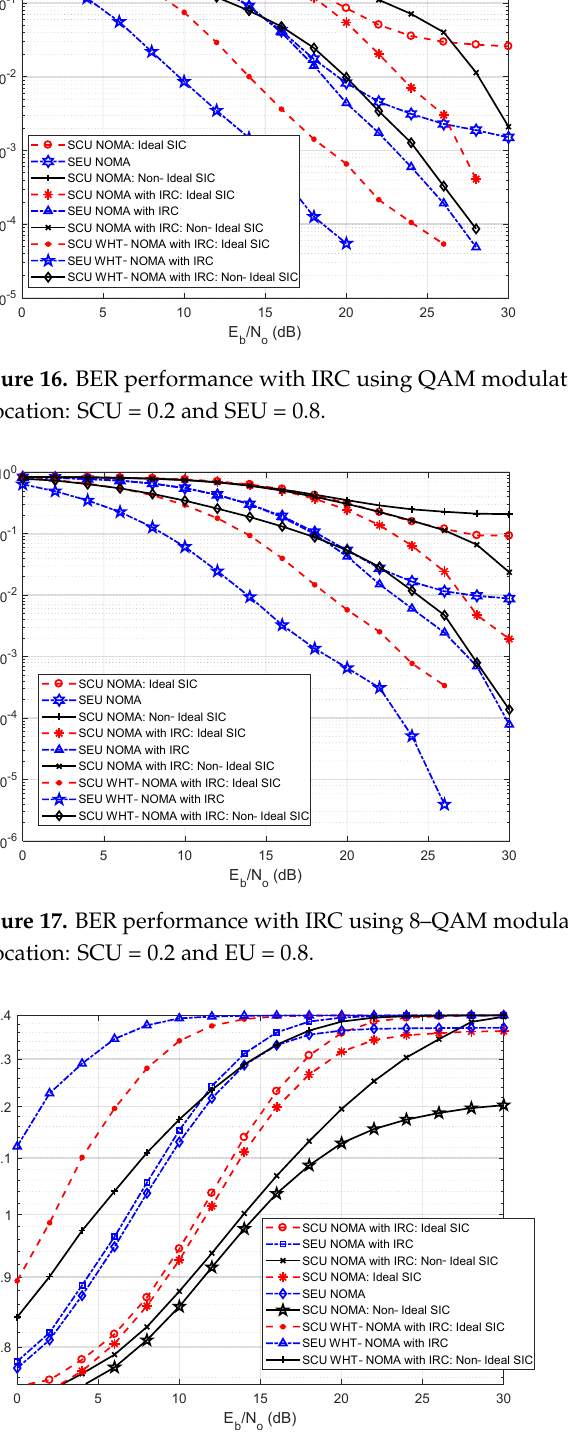
Figure 18. Throughput performance with IRC using BPSK modulation; NOMA vs. WHT–NOMA,